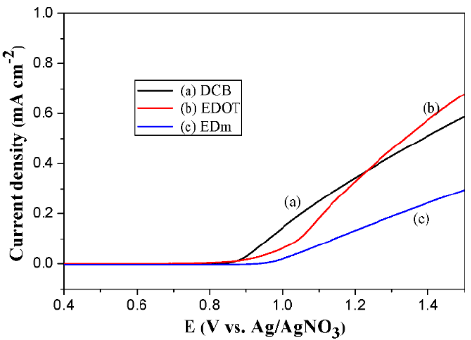
Figure 1. LSV plots of ( a ) 2 mM DCB, ( b ) 2 mM EDOT, and ( c ) 2 mM EDm at 100 mV s − 1 .